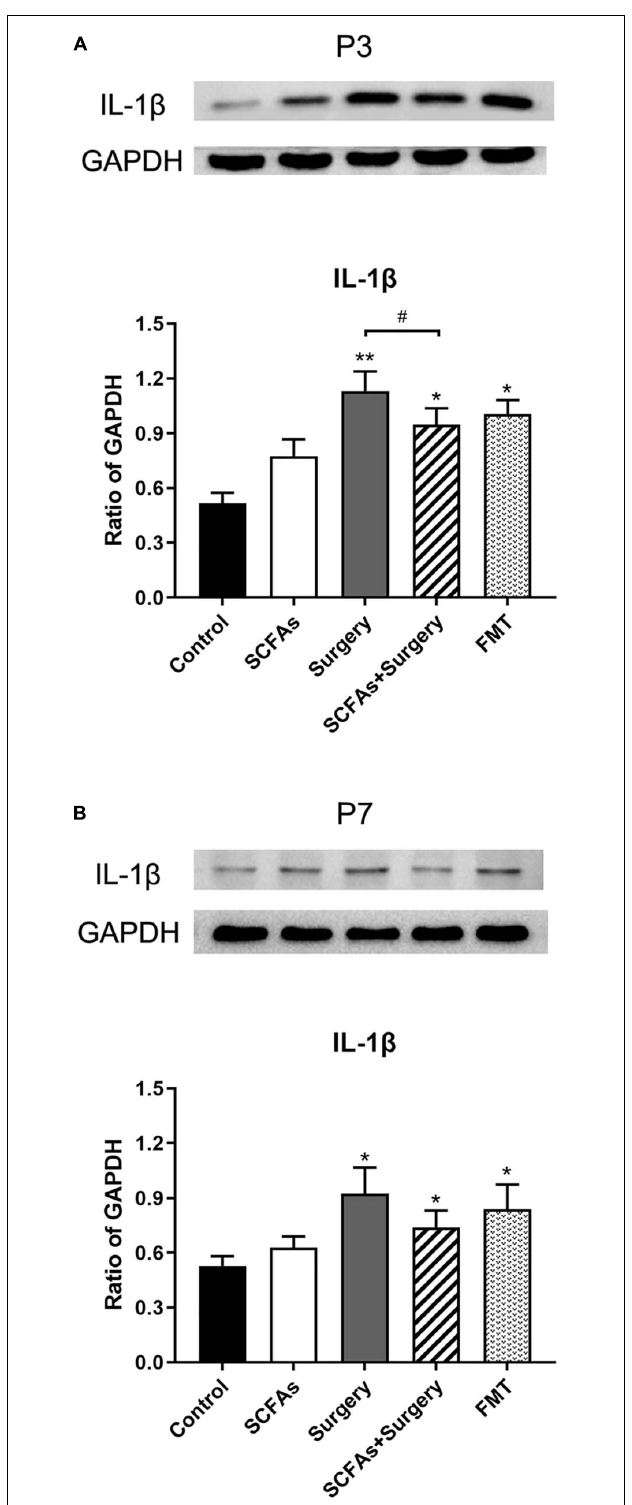
FIGURE 4 | The level of hippocampal IL-1 β was increased following the surgery procedure and fecal microbiota transplantation on postoperative or post-transplantation day 3 compared with the control group. SCFA